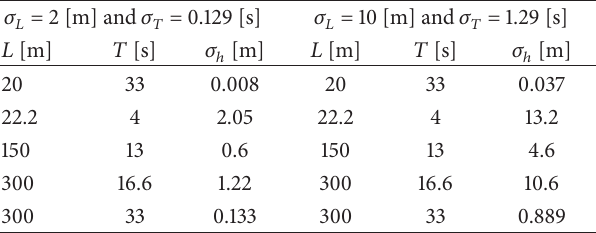
Table 3: Values of uncertainty in the estimated water depth, 𝜎 ℎ , for different ( 𝐿,𝑇 ) and ( 𝜎 𝐿 , 𝜎 𝑇 )